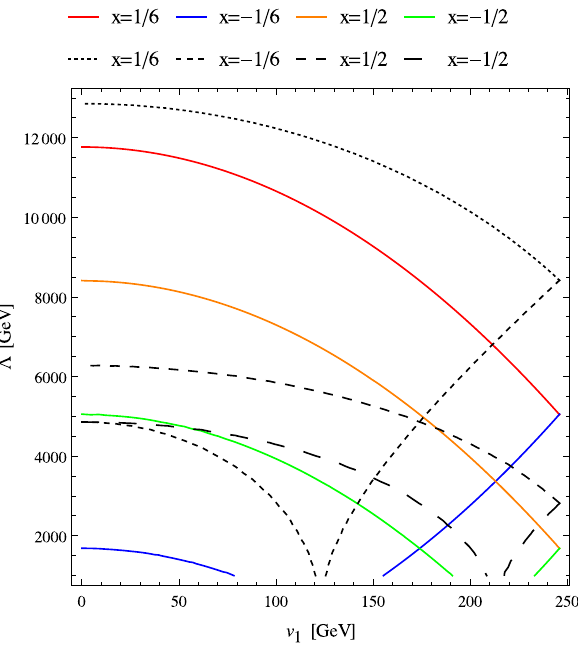
Fig. 2 CDF W -mass deviation contoured as function of (v 1 ,(cid:14)) according to several values of x -charge parameter (solid, color curves). New physics scale (cid:14) limited by the electroweak precision test on | ϕ | (cid:2) 10 − 3 as correspondingly combined (dashed curves)